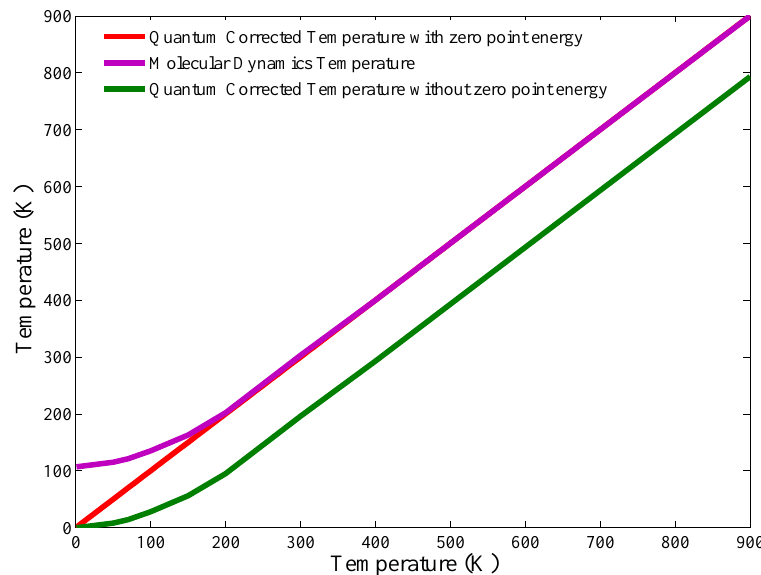
Figure 1. Molecular Dynamics (MD) temperature versus Quantum Corrected temperature for graphene nanoribbon (GNR).